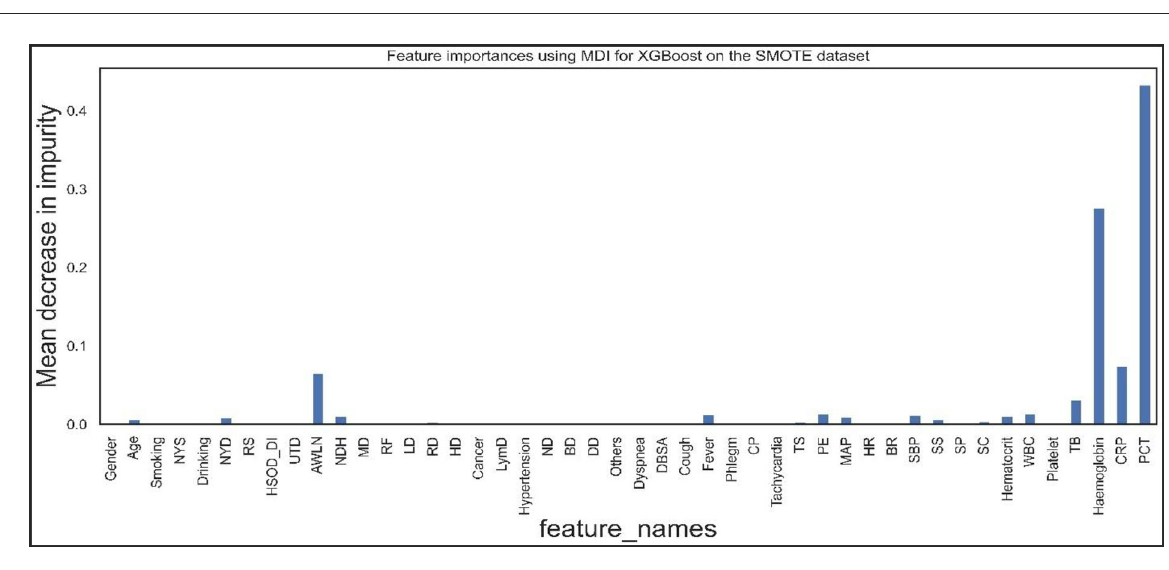
FIGURE9 Feature importance according to the XGBoost model on the SMOTE